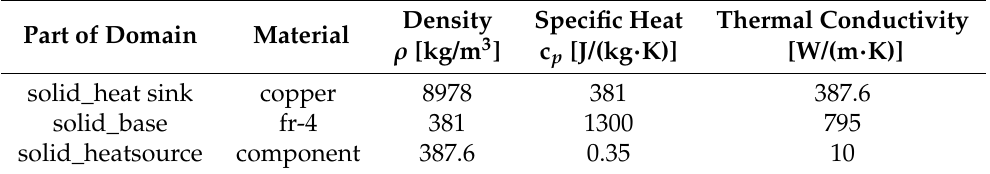
Table 2. Determination of material properties of individual system components. Part of Domain